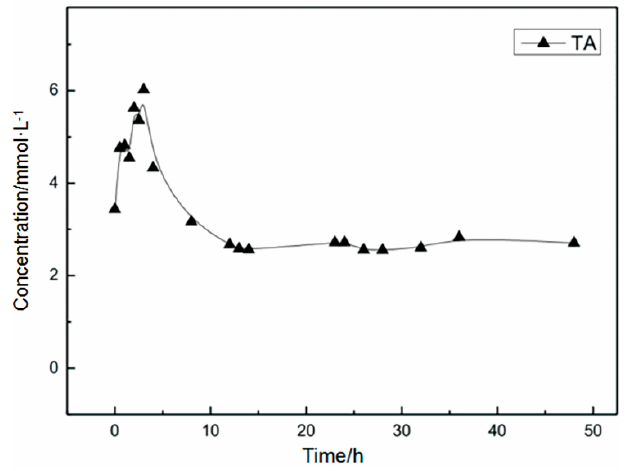
Figure 3. Utilization of TA by strains.